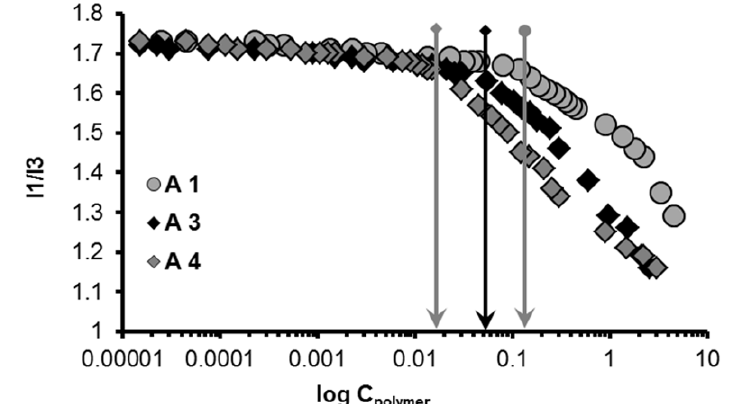
Figure 3. Plots of the I